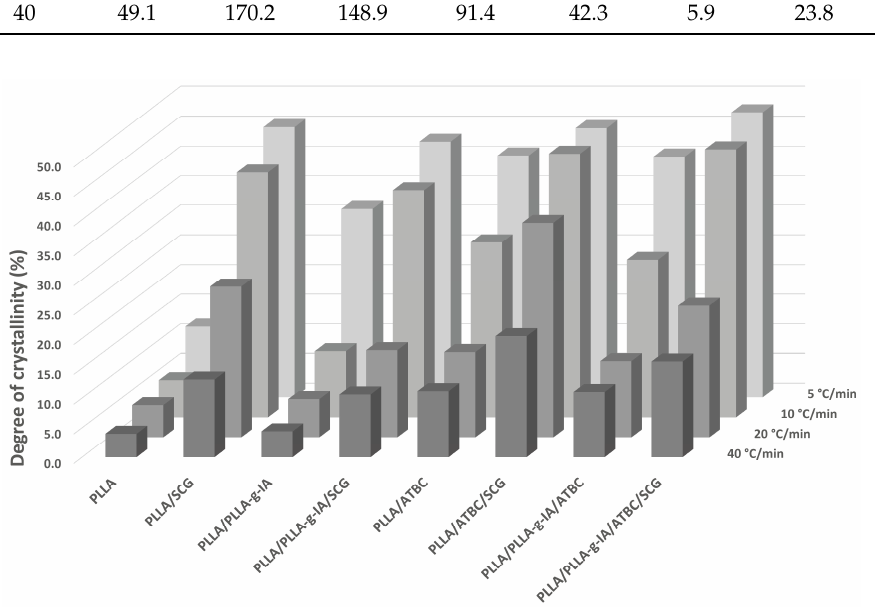
Figure 4. Crystallinity degree of biocomposite structures at different CRs. A positive finding is that the increase in X c is particularly evident even at high CRs, which otherwise generally hinder polymer crystallization. At slow melt CR (5 °C/min), the PLLA/PLLA-g-IA/ATBC/SCG achieved the highest value of X c = 48%, showing an in- crease of 18% compared to PLLA/PLLA-g-IA/ATBC and a fourfold increase compared to neat PLLA matrix. A similar result can be observed for the PLLA/SCG structure. At higher CRs (40 °C/min), the crystallization ability of PLLA is limited. The values of X c show that a higher change in the macromolecule arrangement can be achieved at higher CRs due to the SCG addition; for example, a more than threefold X c increase was observed for the